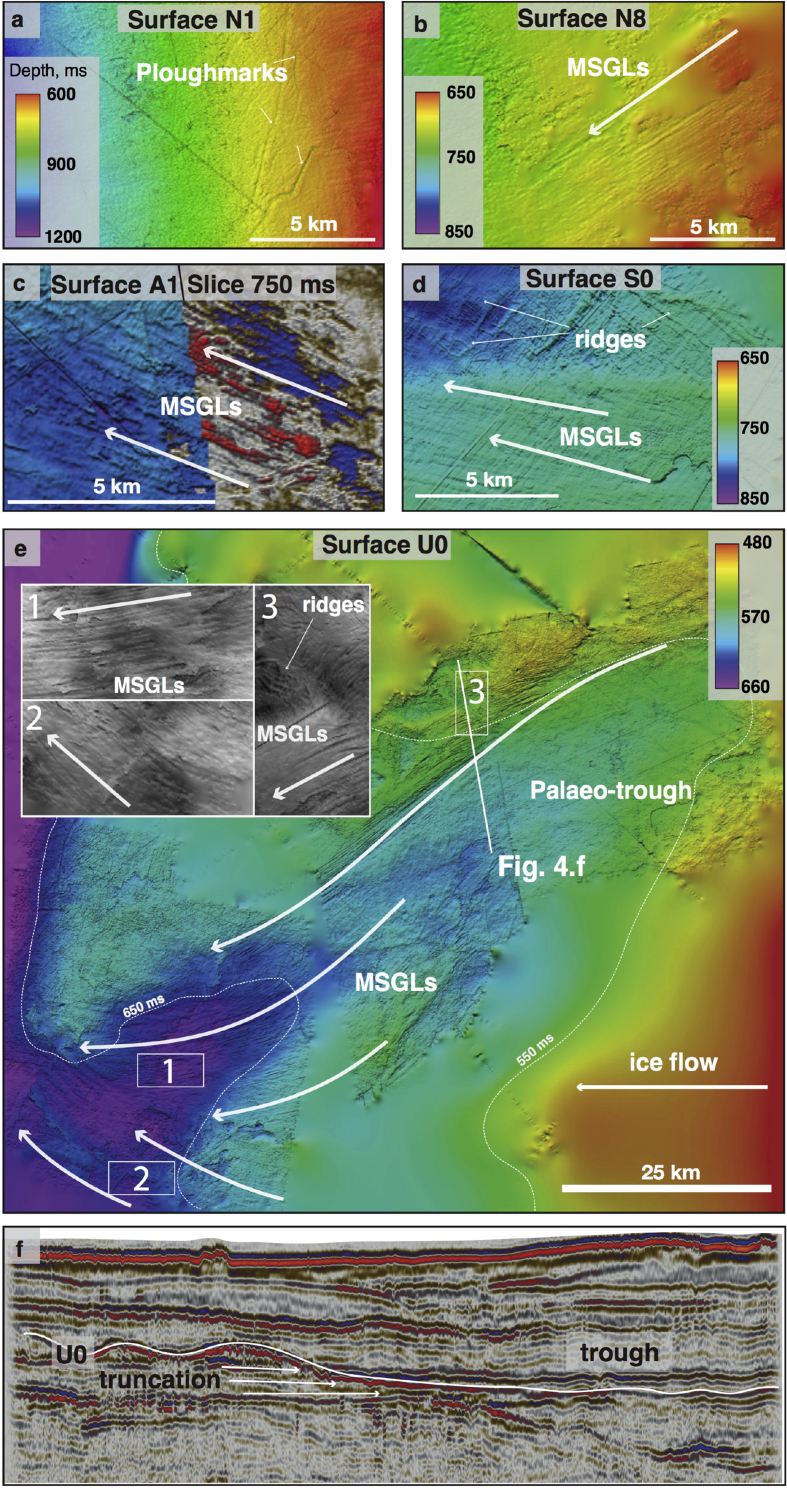
Buried subglacial landforms preserved in the mid-Norwegian continental shelf. a. Buried palaeo-shelf surface N1 with evidence of iceberg ploughmarks on the palaeo-shelf (3D seismic cube NLGS-95). b. Buried palaeo-shelf surface N8 with preserved MSGLs. Arrow indicates inferred direction of former fast ice flow (3D seismic cube GNNR-99). c. Left part: MSGLs found within buried palaeo-shelf surface A1 within the upper Naust Formation. Right part: horizontal seismic slice through the same surface at ∼750 ms deep showing the continuation of the same set of MSGLs (3D seismic cube GNNR-99). d. Streamlined features bordered by the transverse ridges (grey lines) found within the palaeo-shelf of surface S0, in modern Sklinnadjupet (3D seismic cube SG-9605) e. Elongate depression interpreted as a palaeo-trough within the shelf surface S0 (multiple 3D seismic cubes). f. Seismic cross-section profile across the palaeo-trough margin in panel e.